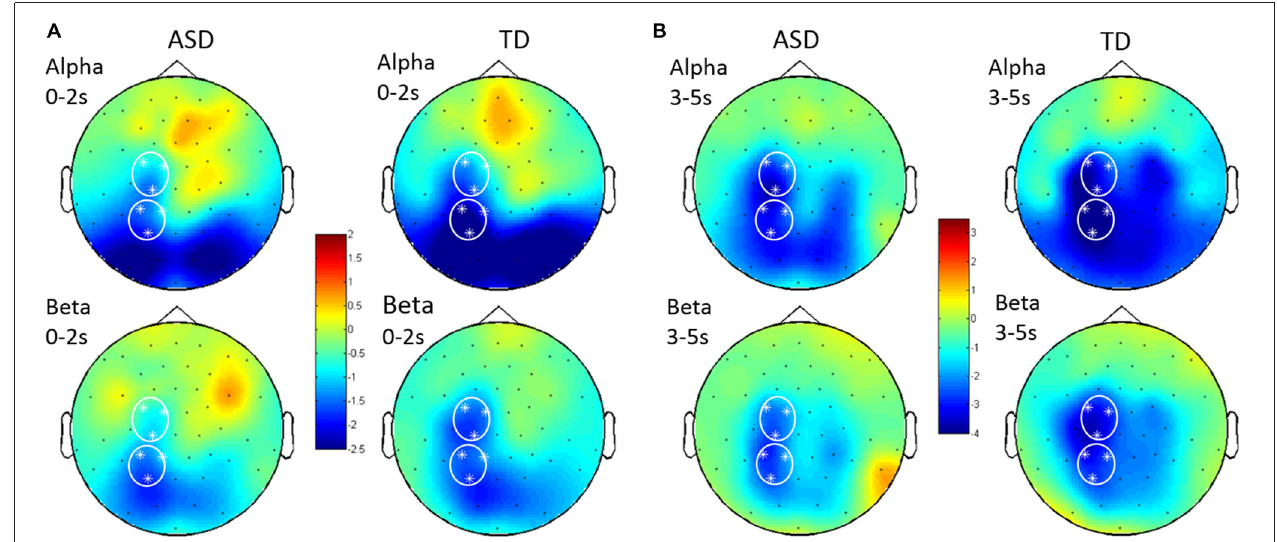
FIGURE 4 | Topographical distribution of alpha and beta ERD in Prepare (A) and Go (B). Alpha ERD (in unitless z -scores) was seen in occipital and parietal scalp regions following Prepare , and beta ERD was seen principally in parietal regions during this phase. Following Go , both alpha and beta ERD were seen in parietal and central (motor/premotor) regions. Signals were analyzed from left central and left posterior ROIs. Grand average topographical plots from children with HFA on the left and typically developing (TD) children on the right.